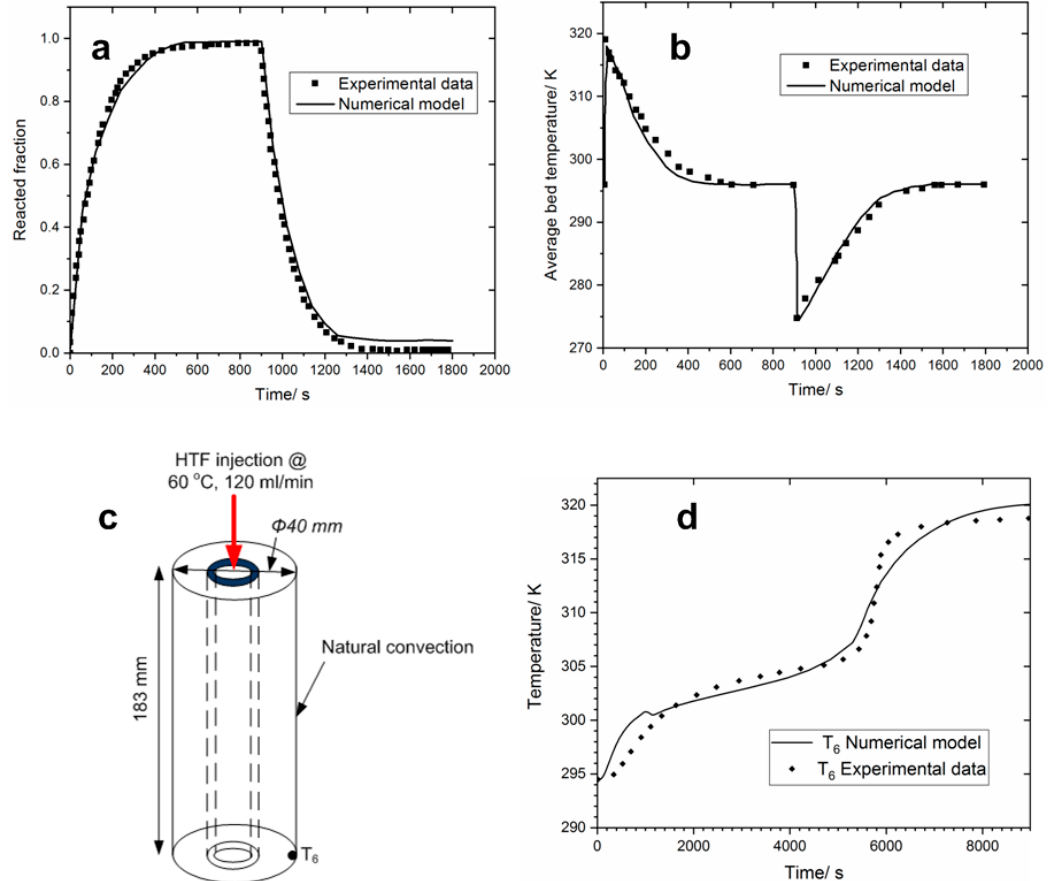
Figure 6. Model validation against experimental data ( a ) average reacted fraction ( b ) average bed temperature ( c ) Schematic of the PCM reactor and experimental condition ( d ) PCM temperature at T 6 [48].